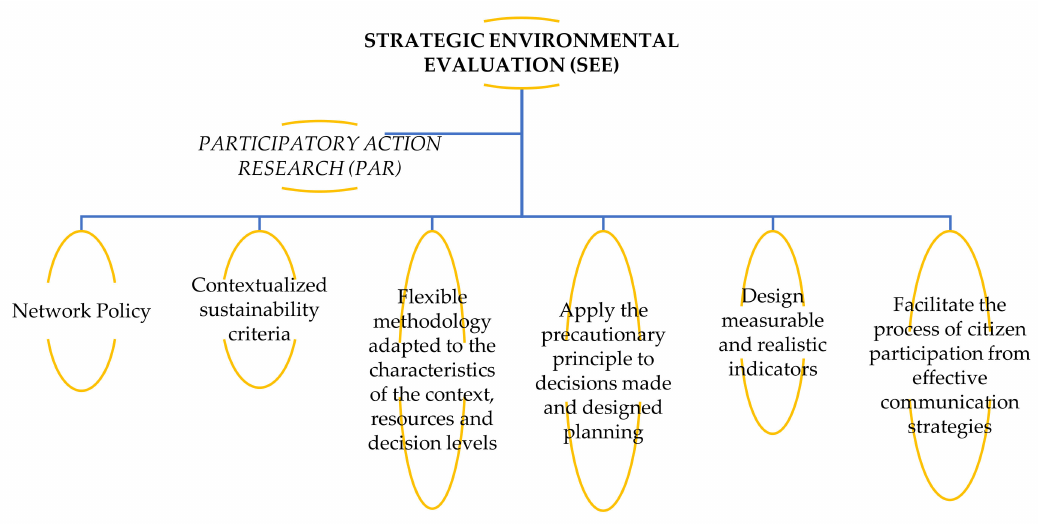
Figure 5. Strategic environmental evaluation: principles of